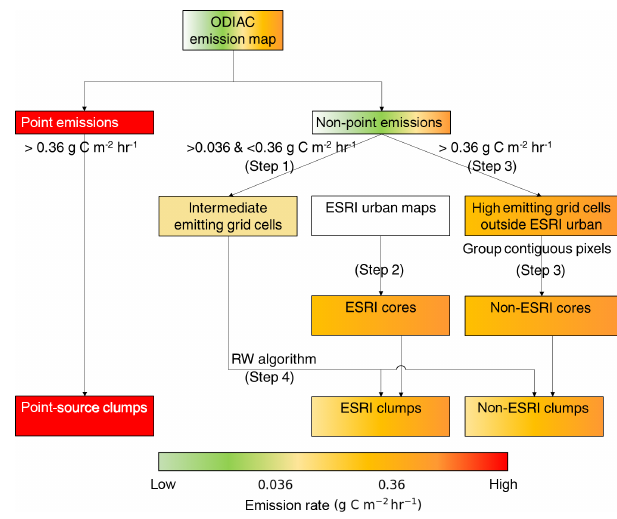
Figure 2. The flow chart for calculating emission clumps. The col- ors qualitatively illustrate grid cell emission rates from low (light green) to high